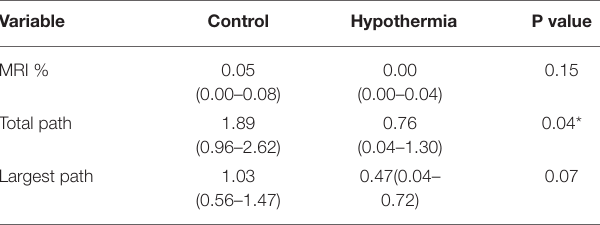
TABLE 1 | Summary statistics of neurological injury in control and hypothermia-treated pigs.